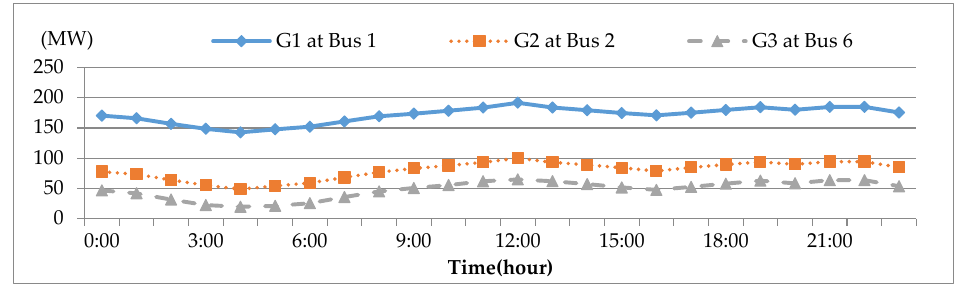
Figure 9. Numerical results for the optimal generation of each unit in the main power grid.